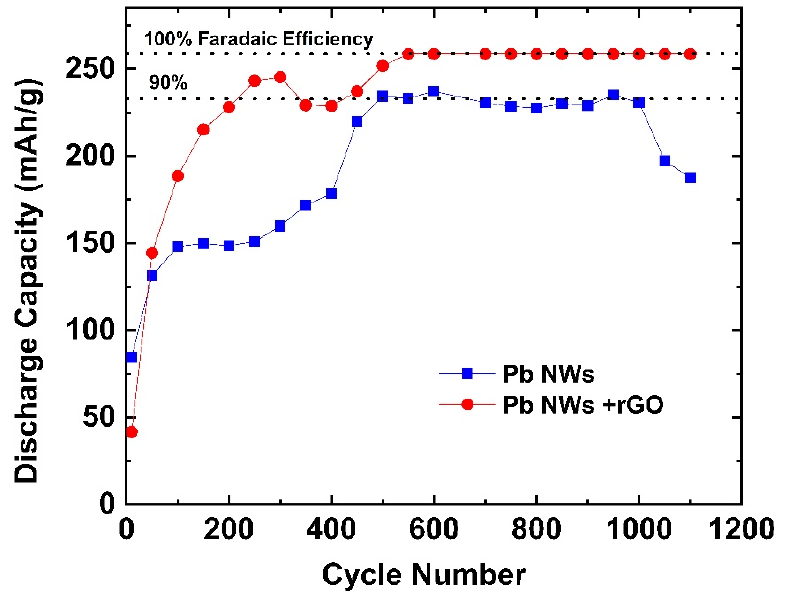
Figure 5. Electrode capacity as a function of cycle number for the nanostructured electrode with rGO and the nanostructured electrode without rGO in 5 M H 2 SO 4 .